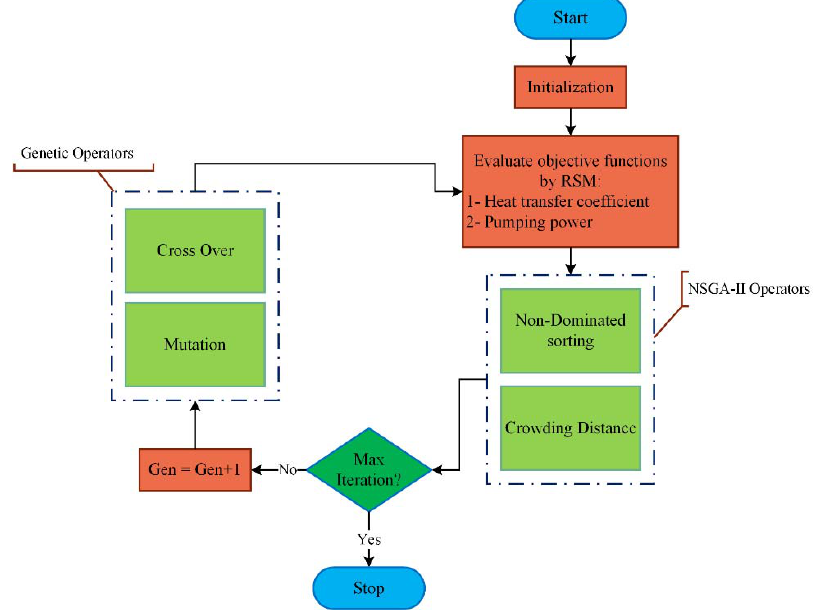
Figure 3. Flowchart of the non ‐ dominated sorting genetic algorithm ‐ II (NSGA ‐ II).